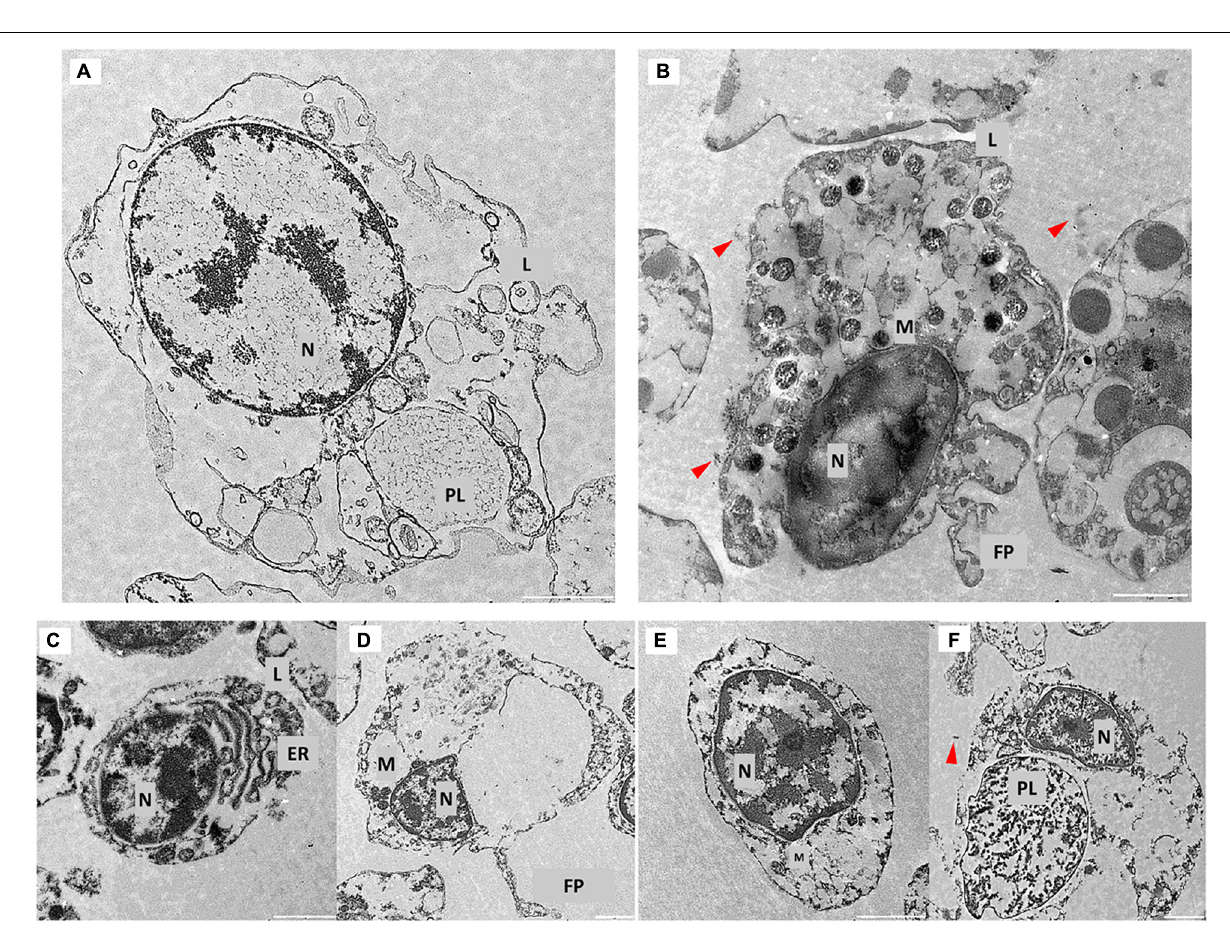
Frontiers in Marine Science |